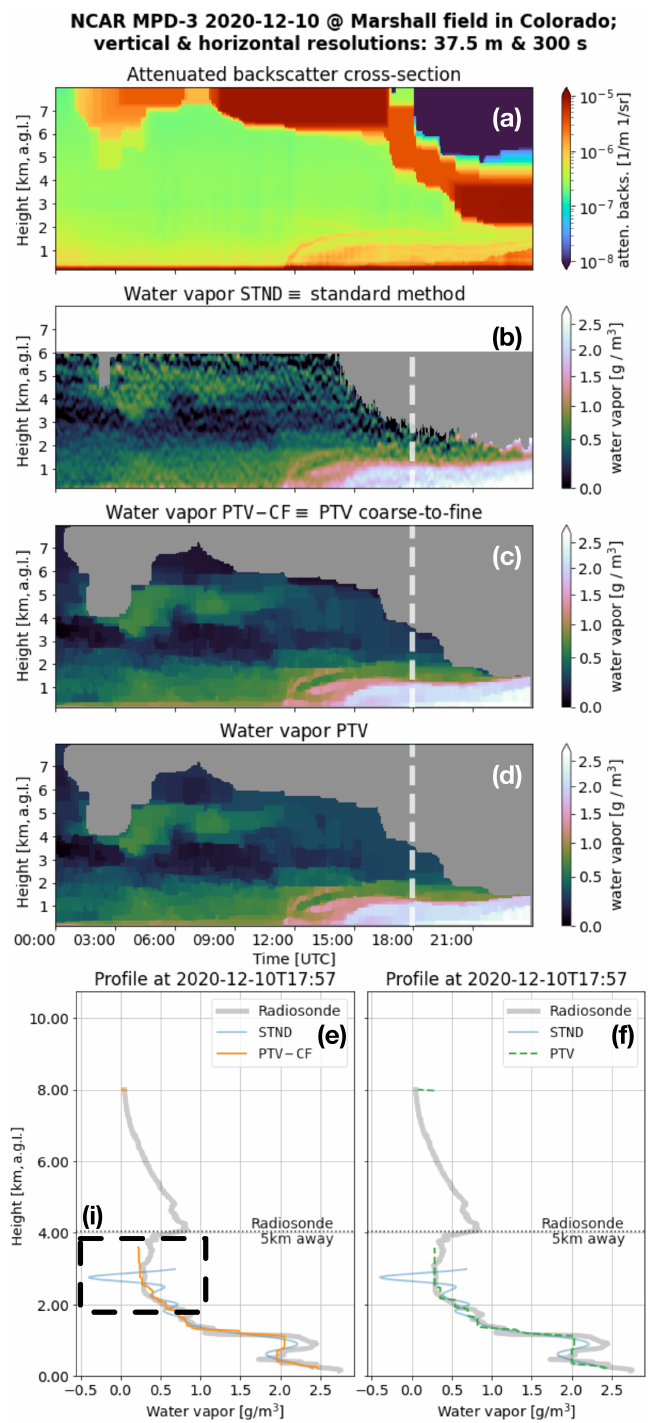
Figure 5. The (a) attenuated backscatter cross section and the water vapor (WV) measurements of the (b) standard method ( STND ) and the PTV-MPD method (c) with ( PTV-CF ) and (d) without ( PTV ) the coarse-to-fine configuration. Panel (a) is not masked to show what atmospheric features have been masked out in (b) to (d) by the gray areas. The dashed vertical white lines in (b) to (d) show the launch times of the radiosondes (RSs), where (e) and (f) show the RS WV profiles. Panel (e) compares the course-to-fine PTV-MPD WV measurements against those of the RS and the standard method, whereas (f) show the same comparison for the PTV-MPD method without the course-to-fine configuration. The horizontal dashed lines in (e) to (f) show the altitude at which the RS was horizontally 5km away from the MPD. The dashed box in (e) highlights a region that is discussed in the